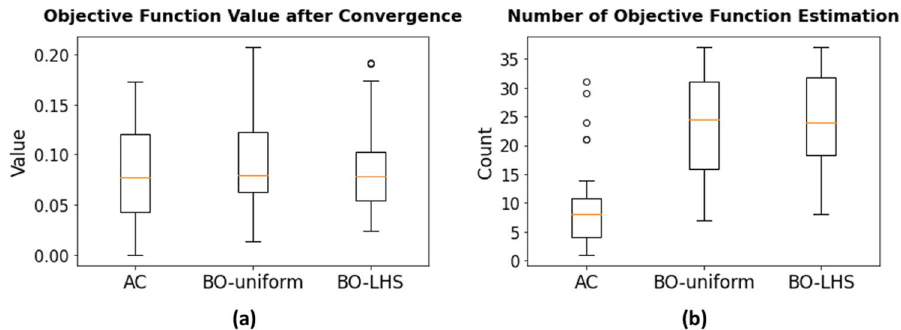
Figure 9. Performance comparison between our GAN-AC framework and a conventional optimization approach (Bayesian optimization; BO). ( a ) While the quality of the solution is on par compared to BO with Latin Hypercube sampling and marginally better than BO with random uniform sampling, ( b ) the AC method is significantly more efficient than BO with both initial sampling strategies (about three times) in terms of the number of objective function